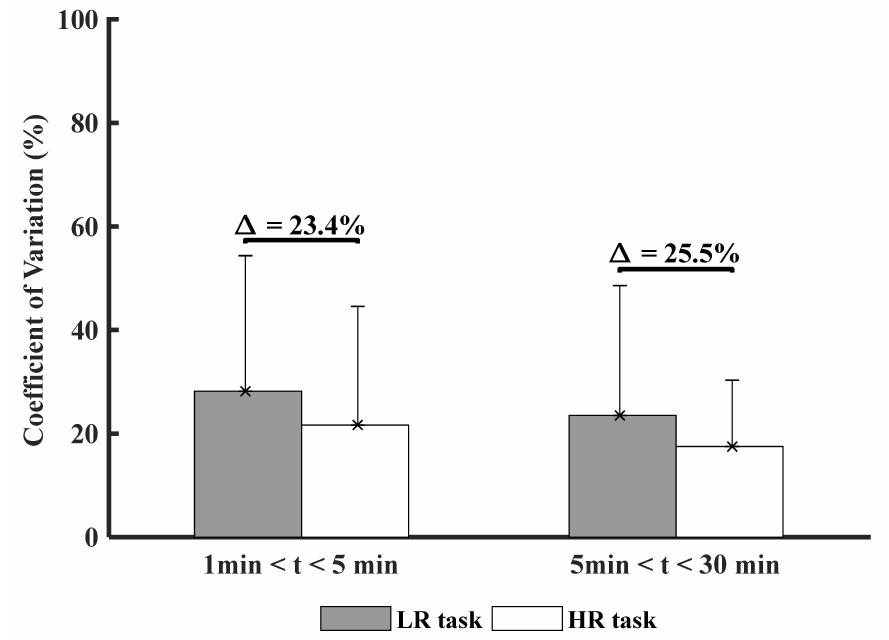
Figure 5. Comparison of the muscle variability for all participants between both experimental task conditions (LR: Low Risk and HR: High risk). ∆ represents the percentage of difference between both experimental task